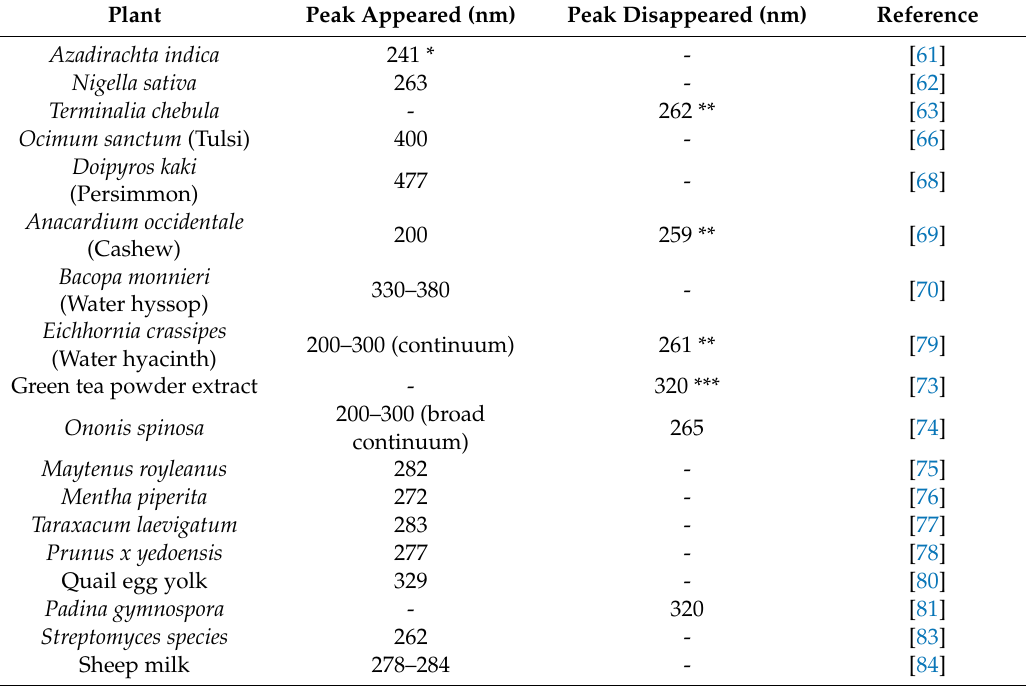
Table 3. UV / Vis absorption bands for the PtNPs synthesized using various biological